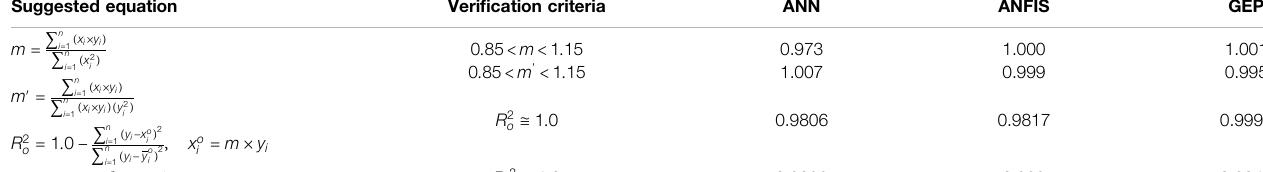
TABLE 7 | Veri fi cation of ANN, ANFIS, and GEP models via criteria suggested in the literature. Suggested equation